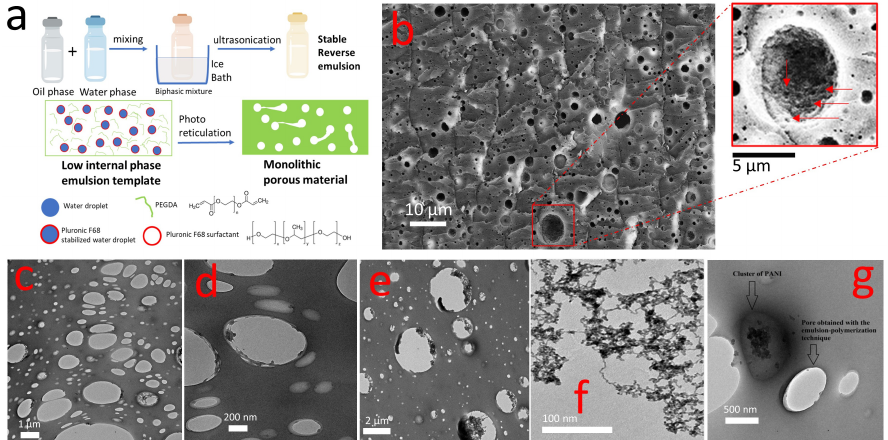
Figure 1. Schematic ( a ) of the fabrication process (Ciba ® DAROCUR ® 1173 photoinitiator is not represented for sake of simplicity); SEM ( b ) and TEM ( c , d ) images showing the internal structure of porous PEG (TEM scale bars 1 um ( c ) and 200 nm ( d ), SEM scale bar 10 um, the red arrows indicate the nanopores present on the walls of a microporous); ( e ) TEM image showing selective inclusion of GNWs (0.4% wt ) into the pores and ( f ) a representative TEM image of the GNWs for comparison; ( g ) selective dispersion of PANI 0.8 wt % in the PEG